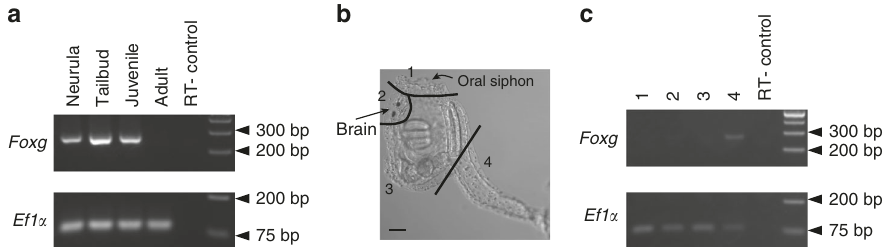
Fig. 2 Foxg is not expressed in the nervous system after metamorphosis. a RT-PCR assay for Foxg expression in neurula embryos, tailbud embryos, juveniles, and adults. Ef1 α expression was examined for a positive control. No ampli fi cation is observed in the negative control (RT- control), in which water was added instead of reverse transcriptase. b A juvenile in the same age used for RT-PCR in ( a ) and ( c ). For preparation of specimens used in ( c ), we cut animals into four pieces as indicated by lines. These four pieces are called specimens 1 to 4. The scale bar represents 50 μ m. c RT-PCR assay for Foxg expression in four pieces of juveniles. Ef1 α expression was examined for a positive control. No Foxg expression was detected in specimens 1